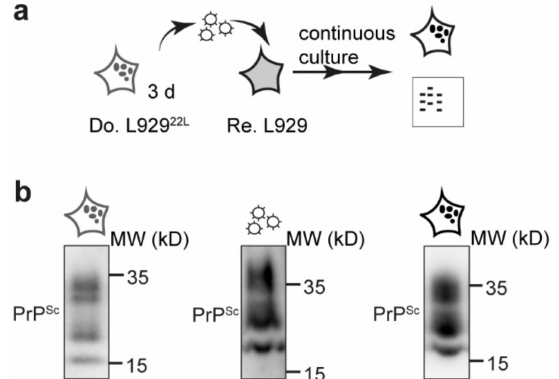
Figure 2. L929 cells infected with 22L secrete PrP Sc and prion infectivity in association with EVs. ( a ) EVs isolated from conditioned medium of L929 cells persistently infected with scrapie strain 22L (L929 22L ) were added to L929 cells. Recipient cells were passaged at least four times before PrP Sc formation was monitored by Western blot. ( b ) Western blot detection of PrP Sc in donor cells (L929 22L ) or PrP Sc in EVs derived from donor cells or PrP Sc in recipient cells after continuous culture. PrP Sc present in proteinase K-treated lysates was detected using anti-PrP antibody 4H1. PrP Sc runs as unglycosylated, monoglycosylated and diglycosylated